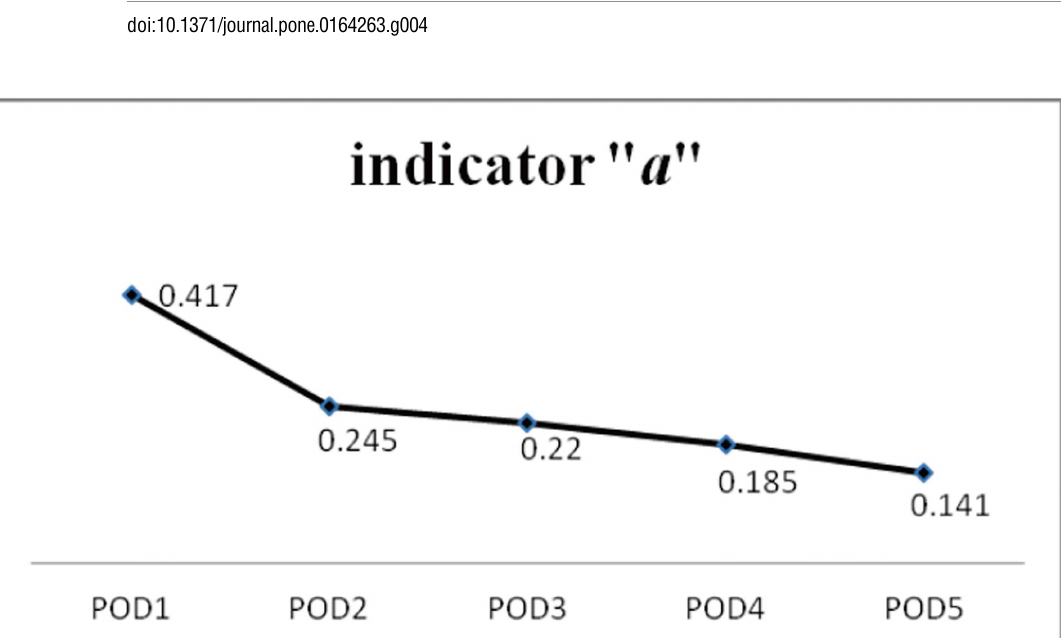
Fig 5. The change of mean of indicator “ a ” in parabolic P-V curve in case 2. The mean of parameter “ a ” declined graduallyfrom 0.417 on POD 1 to 0.141 on POD